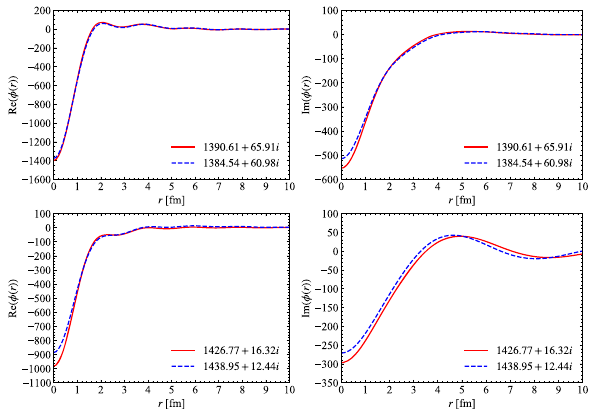
Fig. 8 Wave functions of two poles for the π(cid:4) channel